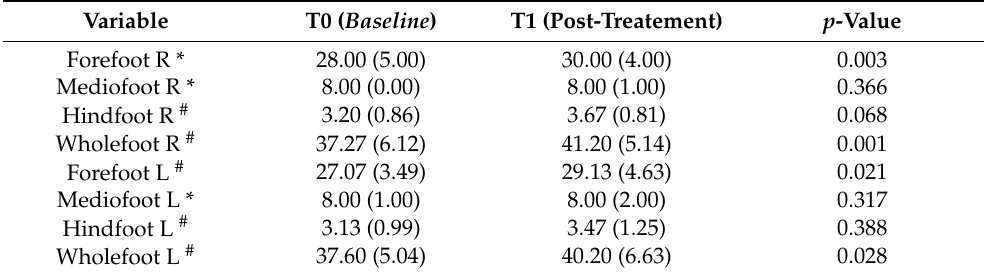
Table 4. Intragroup comparisons (T0 vs. T1) of plantar tactile sensitivity for the exergame group of older women participating in the study. Jequi é , Bahia, 2022.